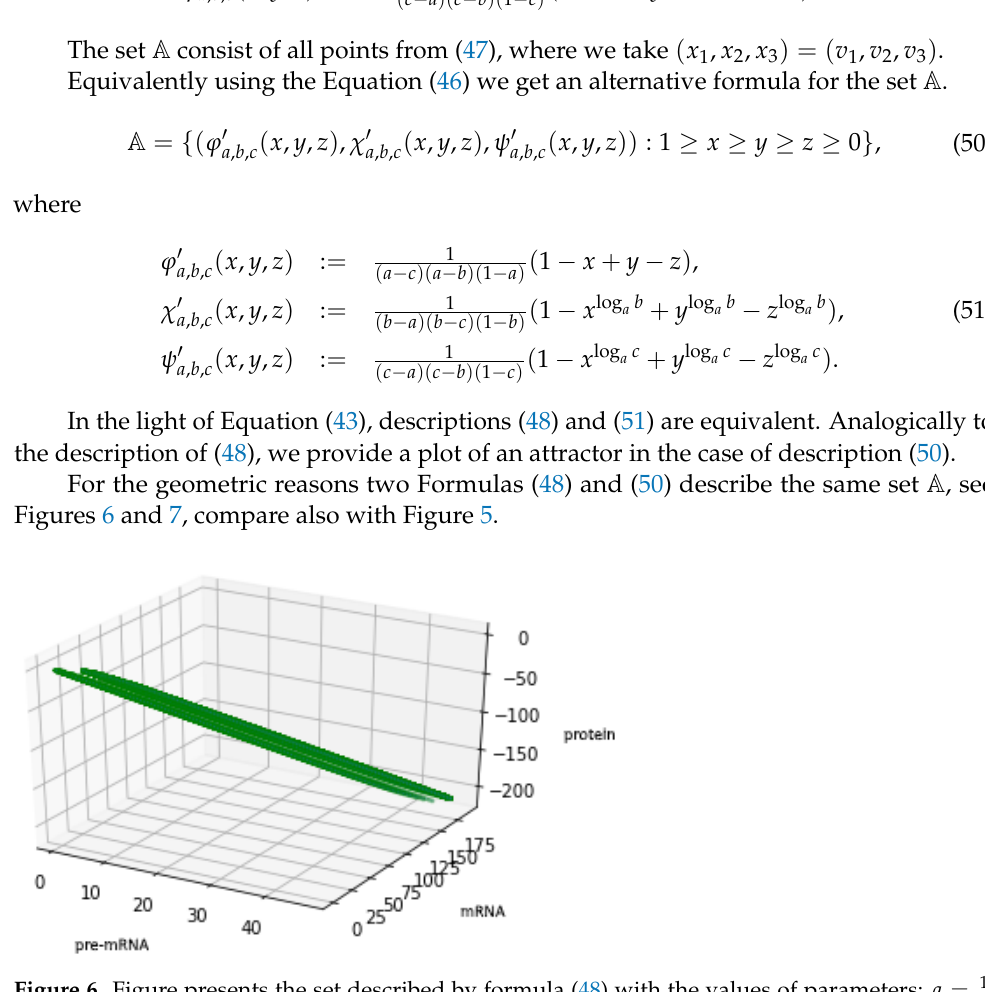
Figure 6. Figure presents the set described by formula (48) with the values of parameters: a = 1 b = 3 , c = 2 . Compare with Figures 3 and 5. 3 4